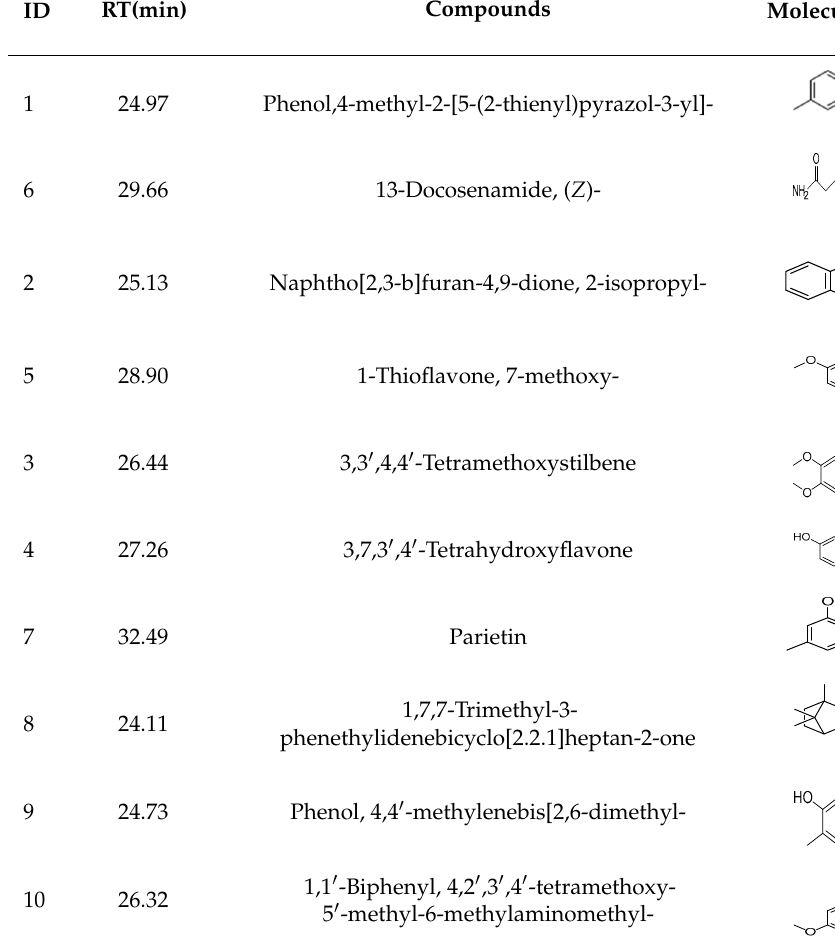
Table 3. Chemical composition of extractives analyzed by GC/MS.